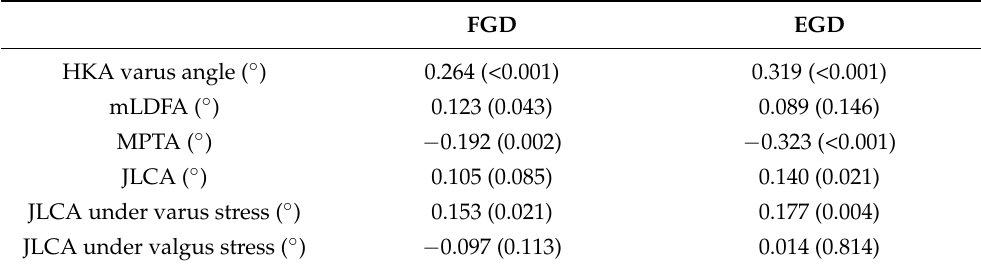
Table 4. Correlations between gap differences and radiologic measurement parameters.